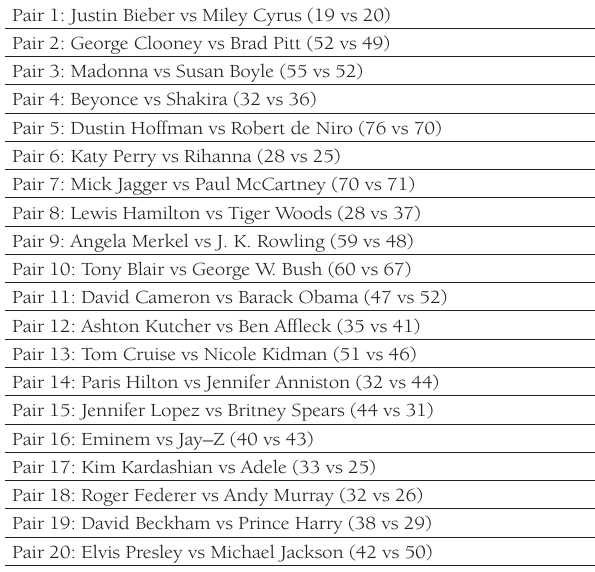
Table 2. Questions posed to a group of 122